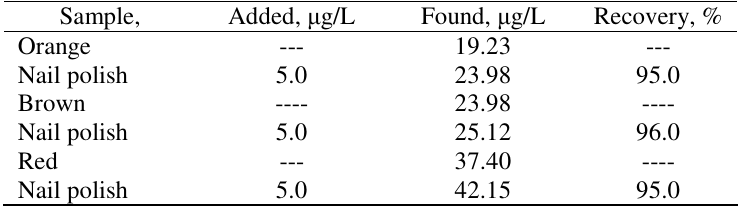
Table 4 . Cd(II) content in nail polish.